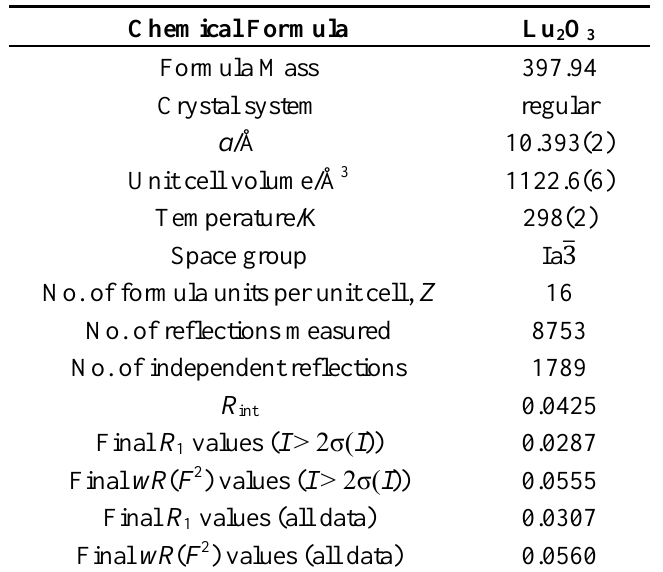
Table 1. Crystal data and structure refinement for Lu 2 O 3